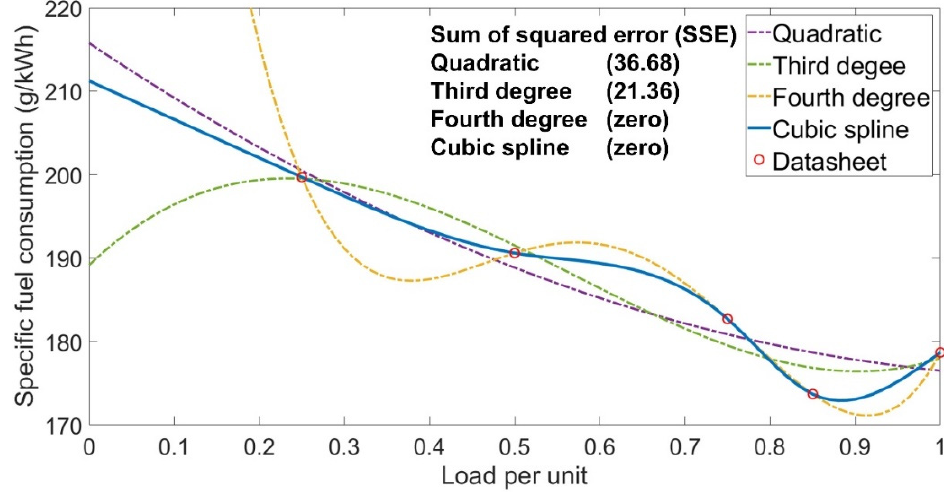
Figure 4. Comparison of interpolation methods.